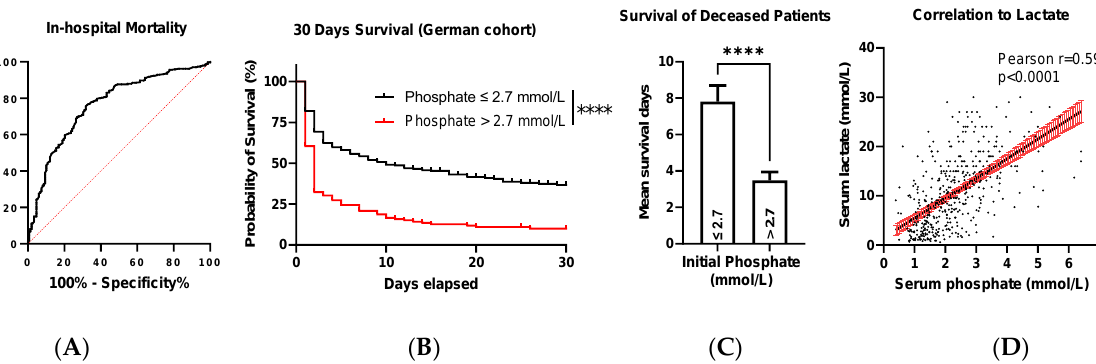
Figure 2. ( A ) ROC curve of serum phosphate levels to predict mortality AUC: 0.7610 (95%-CI: 0.7188–0.8032, p < 0.0001). Cut-off value to predict mortality with 90% specificity: 2.7 mmol/L. ( B ) Kaplan–Meier curve representing the survival of CA patients achieving ROSC in dependency of their initial serum phosphate >2.7 mmol/L (red) or ≤ 2.7 mmol/L (black) (Log-rank (Mantel–Cox) test: **** p < 0.0001). ( C ) Mean survival days of patients with ROSC who ultimately died during the hospital stay dependent on initial phosphate values (median: 2 vs. 3 days; Mann–Whitney test: **** p < 0.0001). ( D ) Correlation between the initial serum lactate and phosphate levels, Pearson r = 0.59 (95% CI: 0.53 to 0.65, R 2 = 0.35, p <